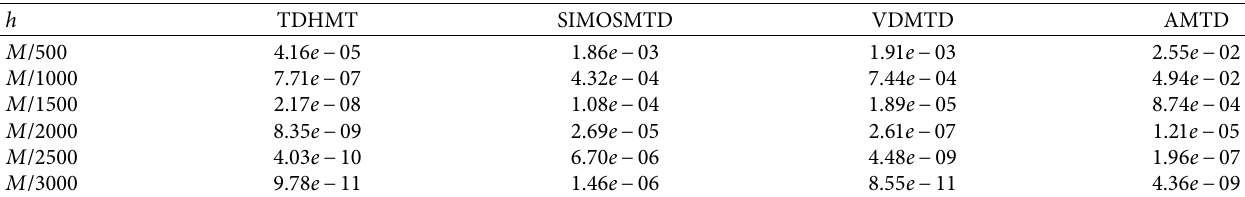
Table 13: Comparison of the absolute errors at the end point of TDHMT with absolute error of other existing methods, namely, SIMOSMTD, VDMTD, and AMTD for Example 5.